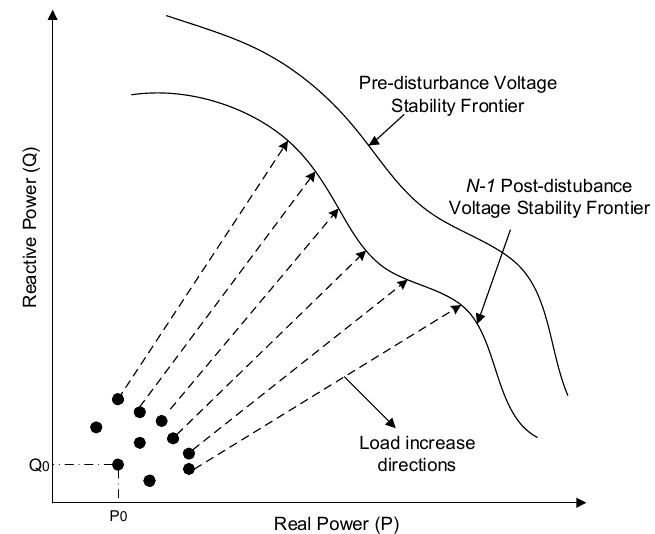
Figure 4. Voltage Stability Margin (VSM) variation due to different operation points, load increase directions and N-1 contingencies.